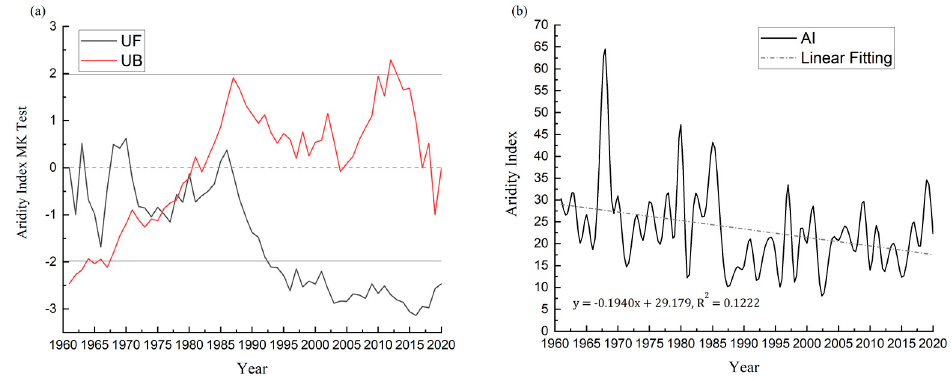
Figure 9. M − K mutation test ( a ) and trend analysis of the aridity index ( b ) in Xinjiang.